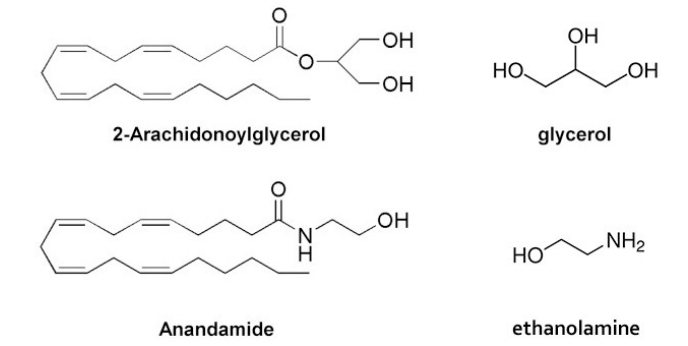
Figure 2. Chemical structures of the analyzed molecules.